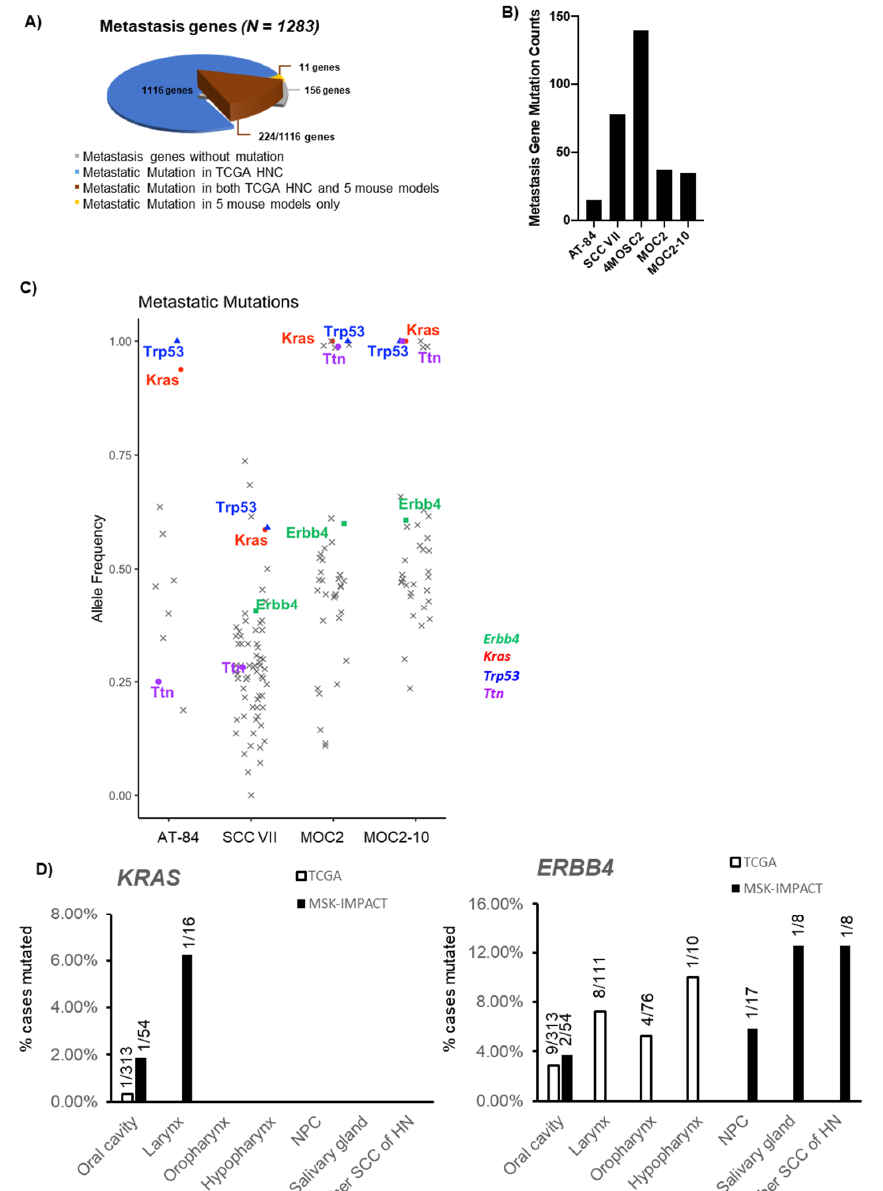
Figure 4. Genetic analysis of 5 mouse models reveals metastasis-related alterations. ( A ) Pie chart showing the number of metastasis-related genes altered in 5 mouse models vs. TCGA-HNC patient tumors ( N = 510). ( B ) Bar graph showing somatic mutation counts of metastasis-related genes in each of the five mouse models. ( C ) Scatter plot showing allele frequencies of metastasis-related gene mutations in each mouse model. Mutations harbored by all 5 mouse cell lines or highly related to cancer metastasis are highlighted with different marks, as displayed on the right. ( D ) Bar graph showing the mutation rates of KRAS and ERBB4 in HNC patient tumors from the TCGA cohort (white bars) vs. the metastatic HNC from the Memorial Sloan Kettering Cancer Center (MSK)-IMPACT cohort (black bars). Detailed subsites are shown. NPC: nasopharyngeal carcinoma; SCC: squamous cell carcinoma; HN: head and neck.